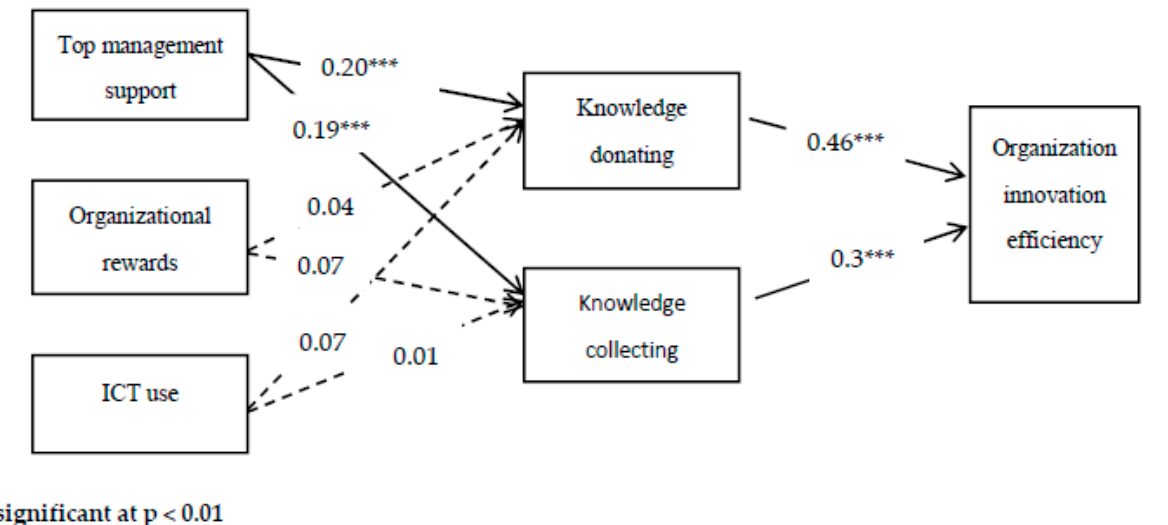
Figure 2. Results of the structural model.